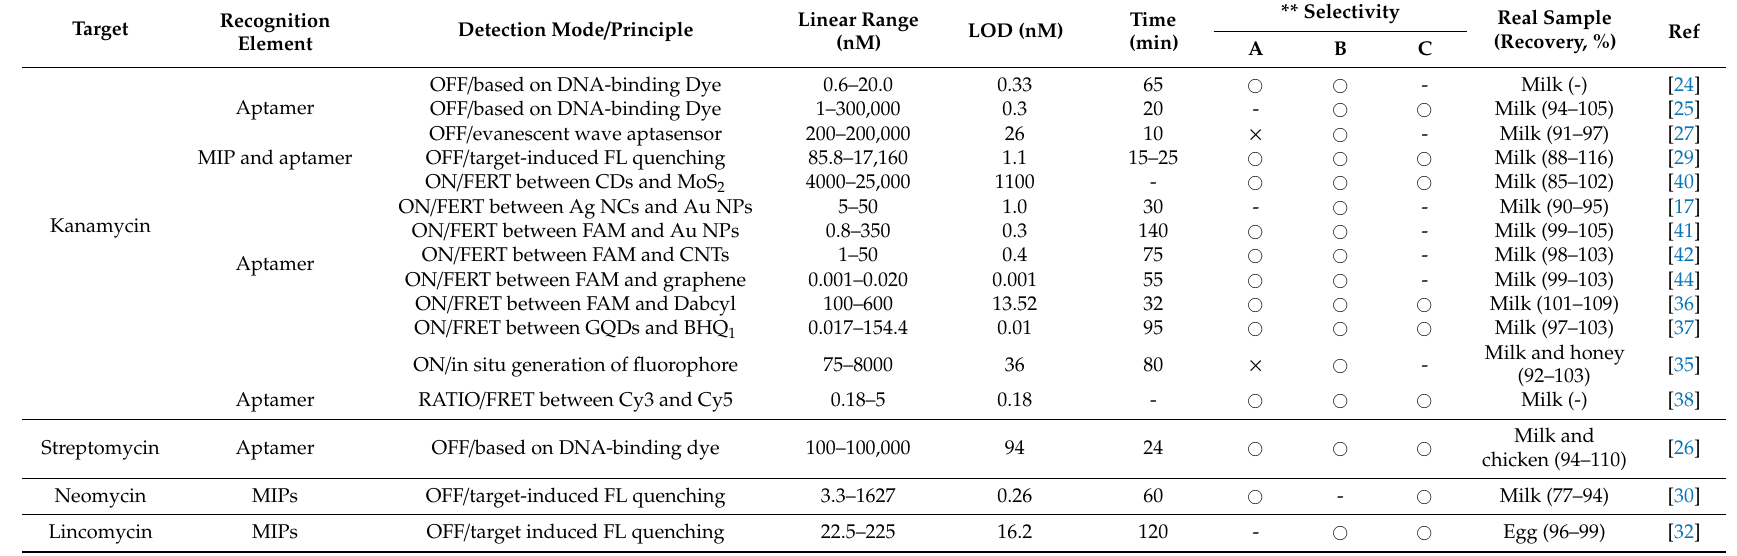
Table A1. Assay performance of typical FL methods for the detection of AGs in food